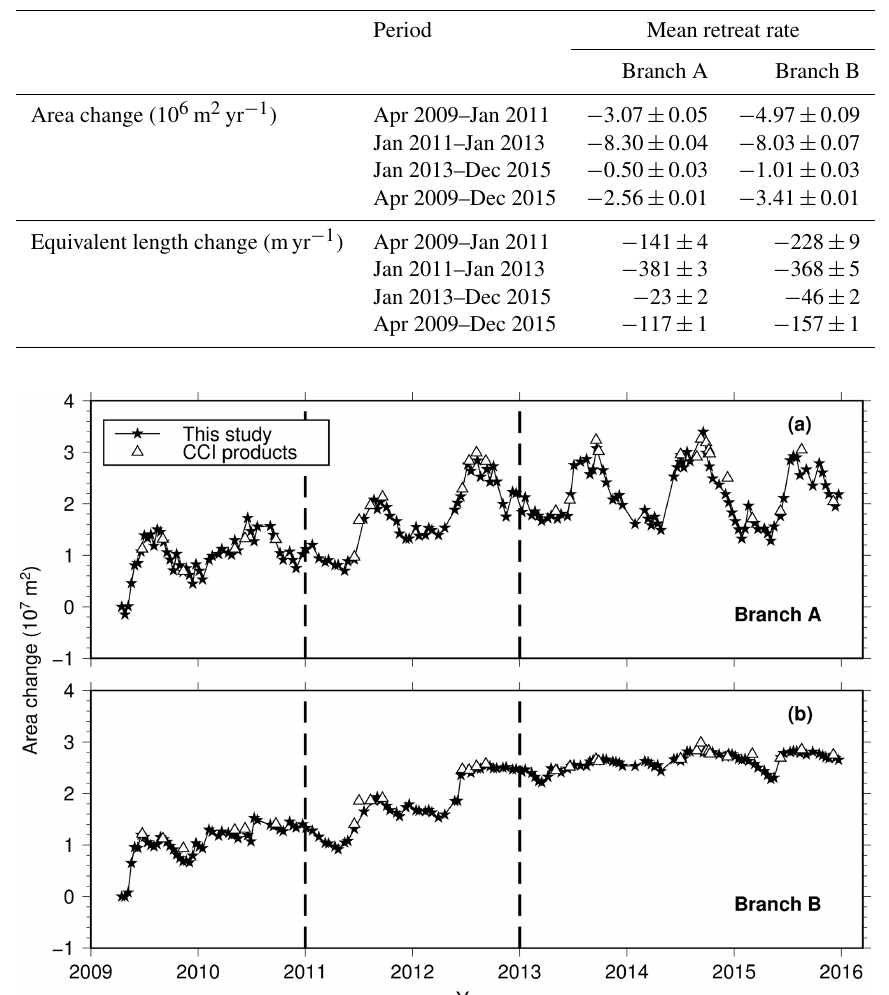
Figure 5. Time series of calving front variations (in area changes) of branches A and B from our deep learning method (stars) and the Greenland Ice Sheet CCI project (triangles). Dashed vertical lines divide the time series into three separate phases (see